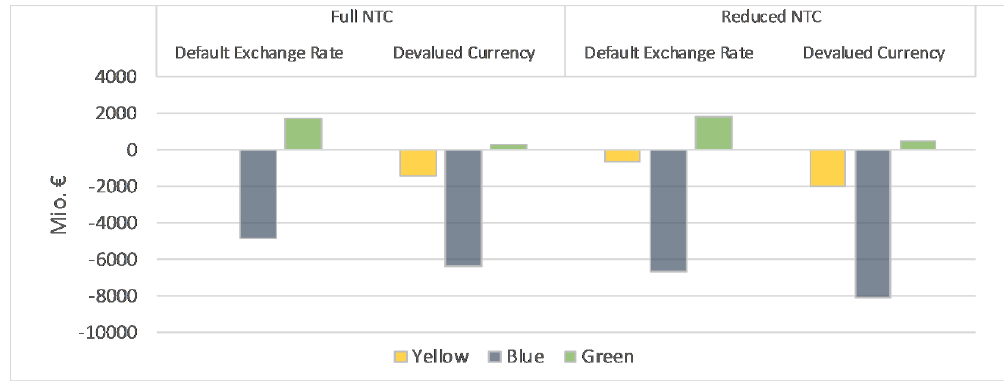
Figure 4. Changes in consumer surplus in comparison to the Yellow scenario. Source: Own calculation.